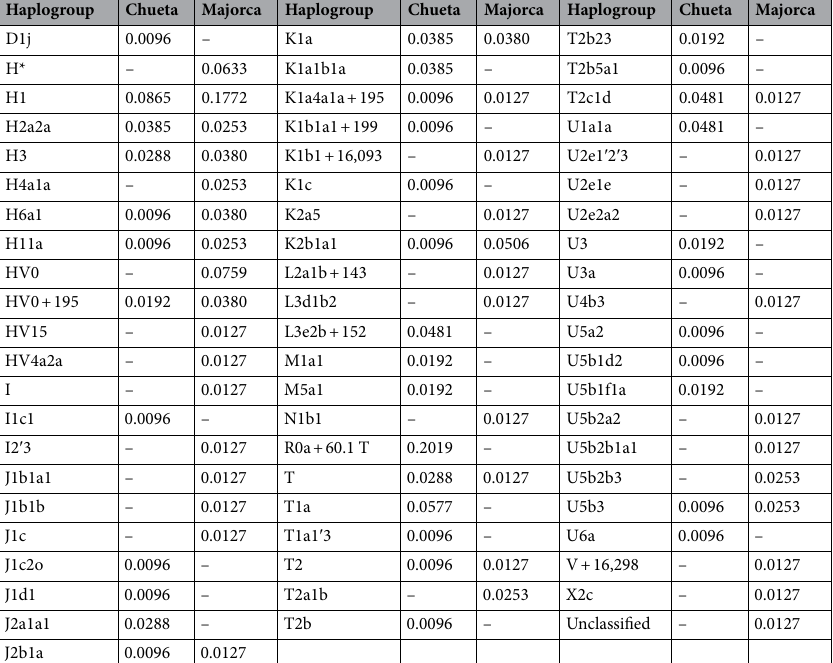
Table 3. Haplogroup frequencies in Chueta and Majorcan